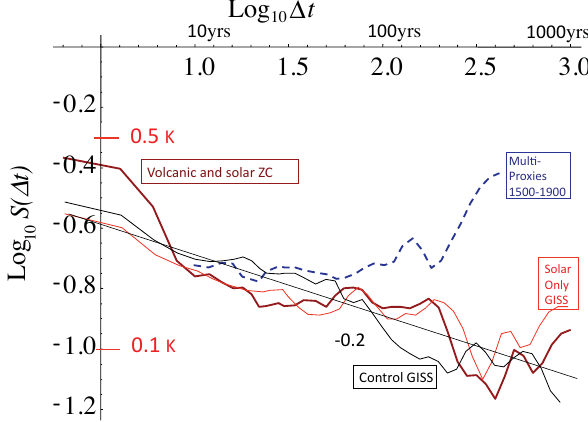
Figure 4. A comparison of the Zebiak–Cane (ZC) model combined (volcanic and solar forcing) response (bold, brown) with GISS-E2- R simulations with solar-only forcing (red) and a control run (no forcings, black), the GISS structure functions are for land, Northern Hemisphere, reproduced from Lovejoy et al.